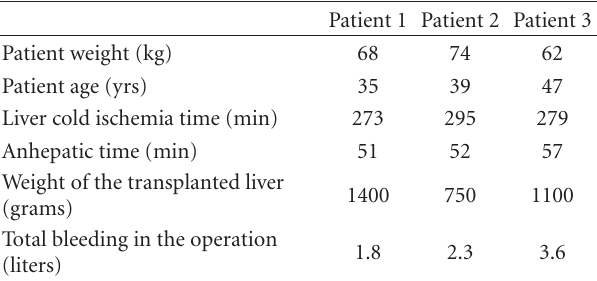
Table 1: Patient